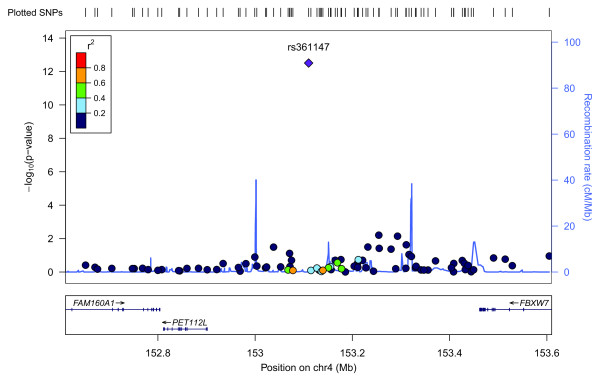
Plot of regional association signals for rs361147 forwarded for validation.